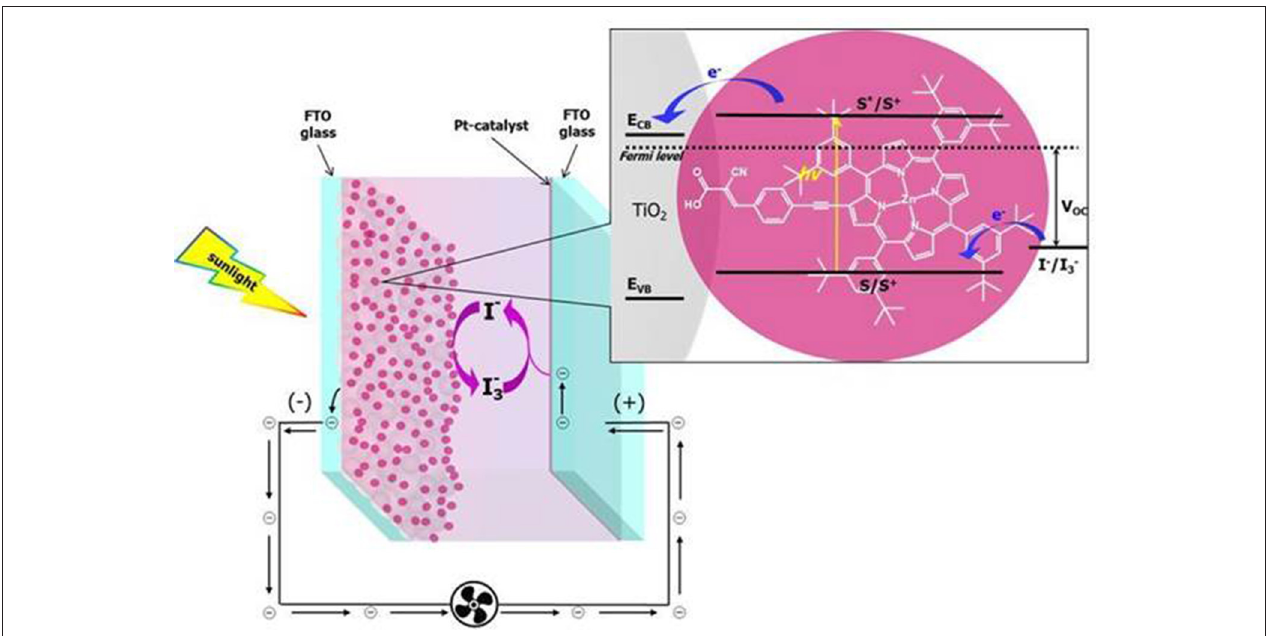
FIGURE 1 | Working principle of a dye-sensitized solar